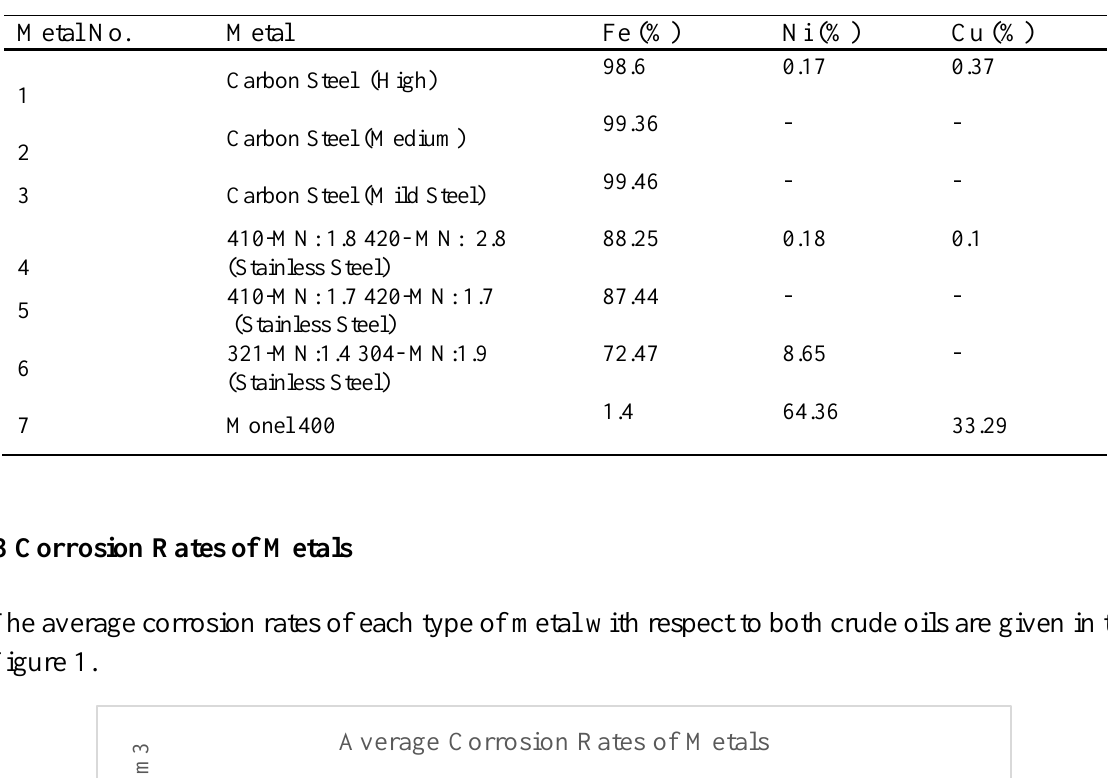
Table 3. Chemical composition of used metals according to the XRF detector.